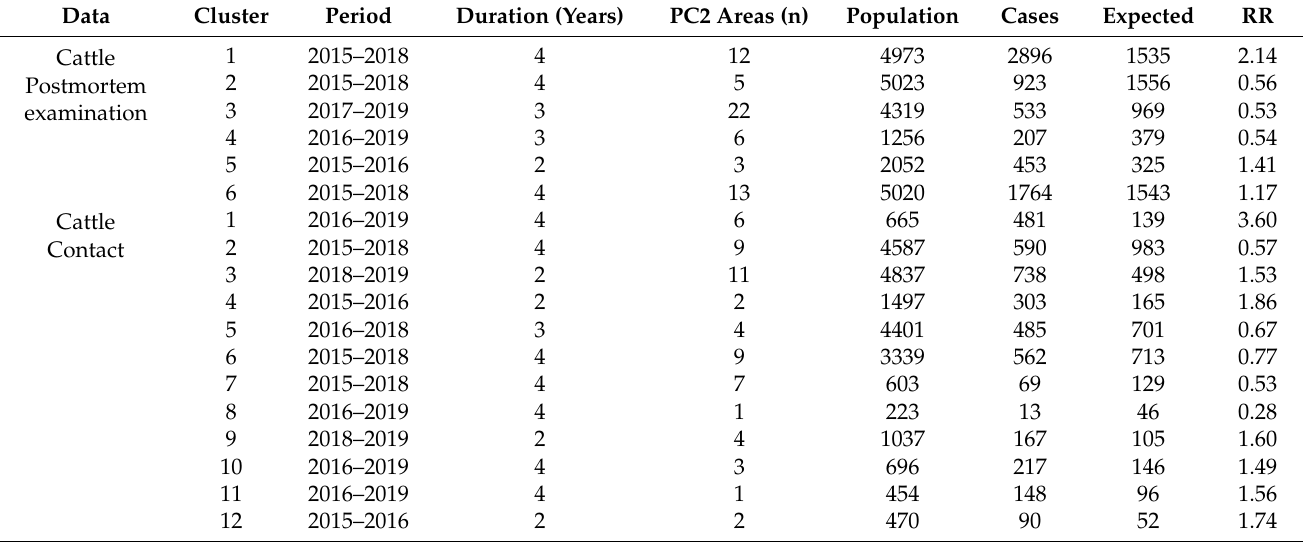
Figure A1. Clinical signs from 2015 to 2019 registered at the veterinary helpdesk for cattle and pigs in the Dutch national surveillance program. Table A2. Space-time clusters ( p > 0.01) of postmortem examination and helpdesk contacts for pigs and cattle between 2015 and 2019 in the Netherlands .